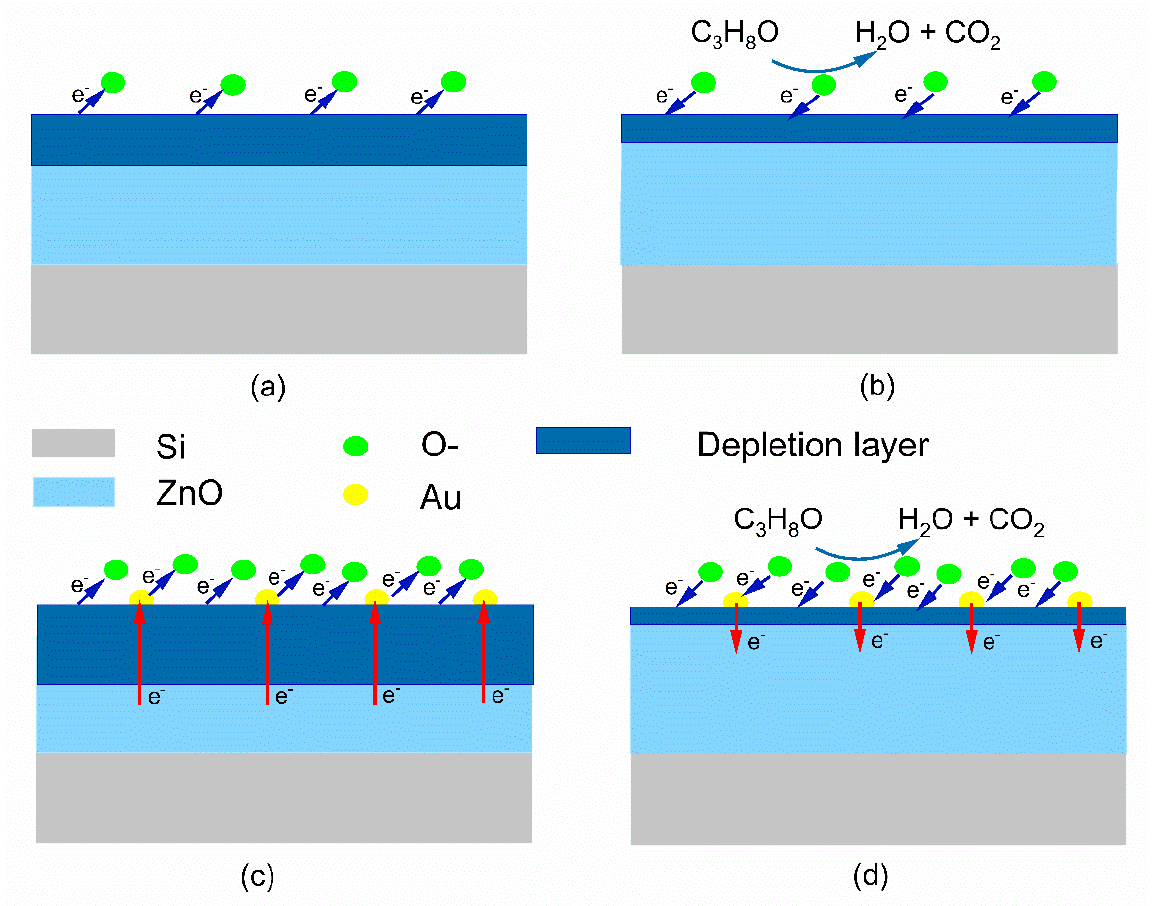
Figure 8. Schematic diagram of the sensing mechanism for pure ZnO nanofilm ( a , b ) and Au@ ZnO nanofilms ( c , d ).